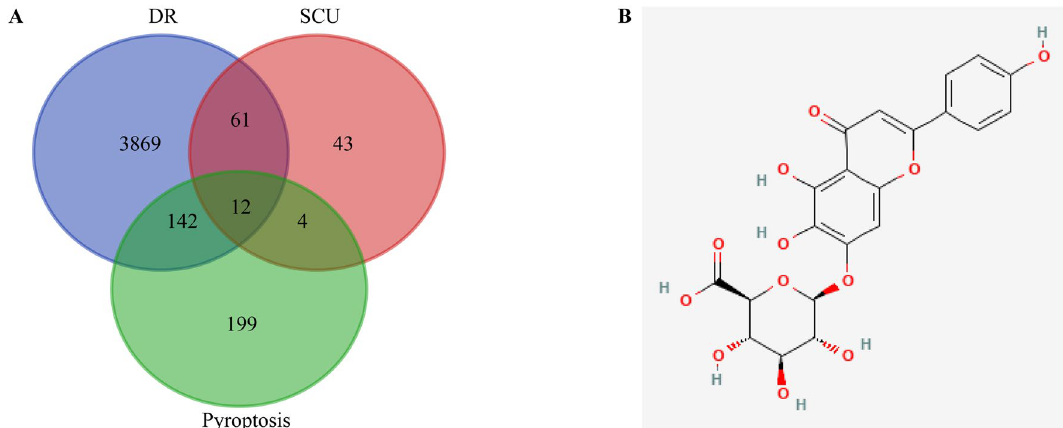
Figure 3. Venn diagram and 2D structure of SCU. ( A ) Venn diagram of the targets of SCU for the treatment of DR. ( B ) 2D structure of